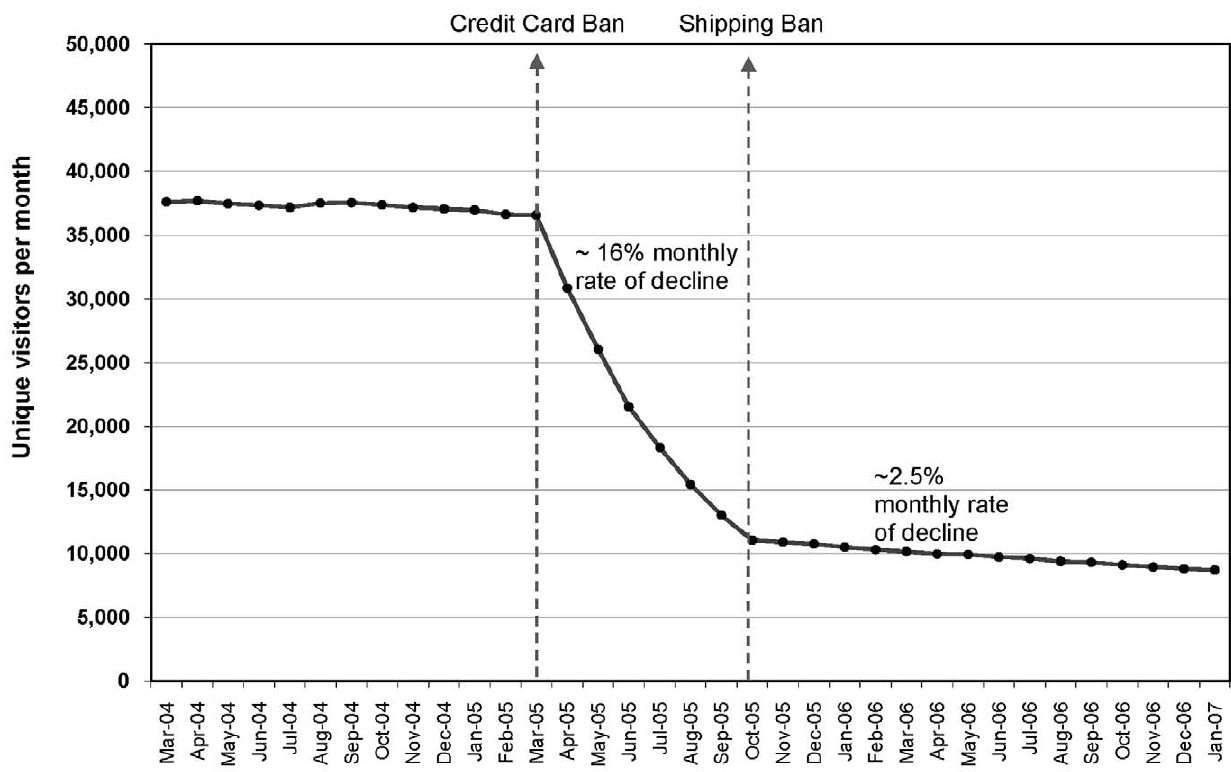
Figure 4. Visitor traffic for 50 most popular Internet cigarette vendor websites, adjusted for Internet traffic growth. Average predicted traffic for the 50 most popular Internet cigarette vendor websites, adjusted for Internet traffic growth (March 2004 to January 2007).